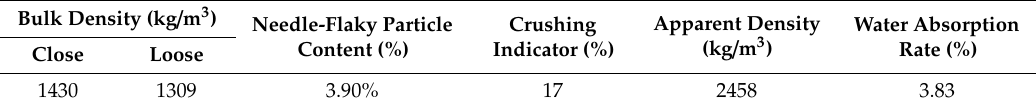
Table 1. Physical properties of recycled coarse